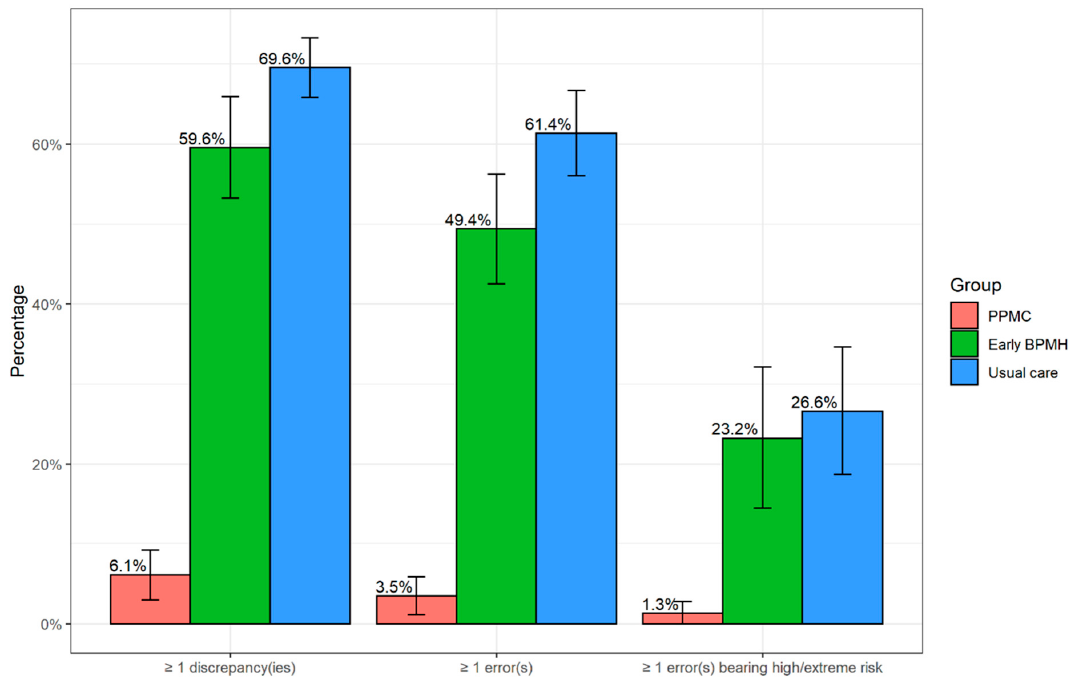
Figure 3. Patients who had at least one discrepancy/error and error bearing high/extreme risk. Abbreviations: BPMH, best-possible medication history; PPMC, partnered pharmacist medication charting. Error bars denote 95% confidence